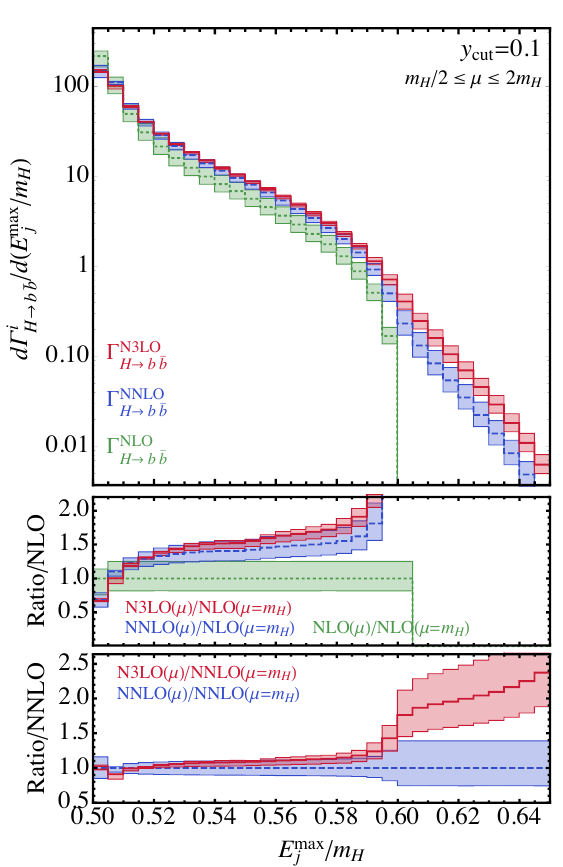
Figure 8 . The energy component of the four-vector for the jet with maximum energy rescaled by the Higgs mass in the Higgs rest frame at NLO, NNLO, and N 3